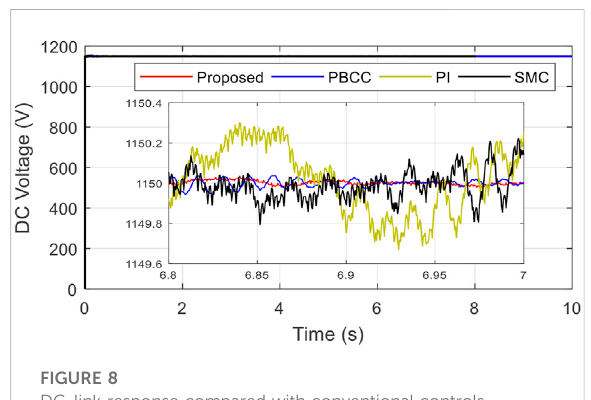
FIGURE 8 DC-link response compared with conventional controls.